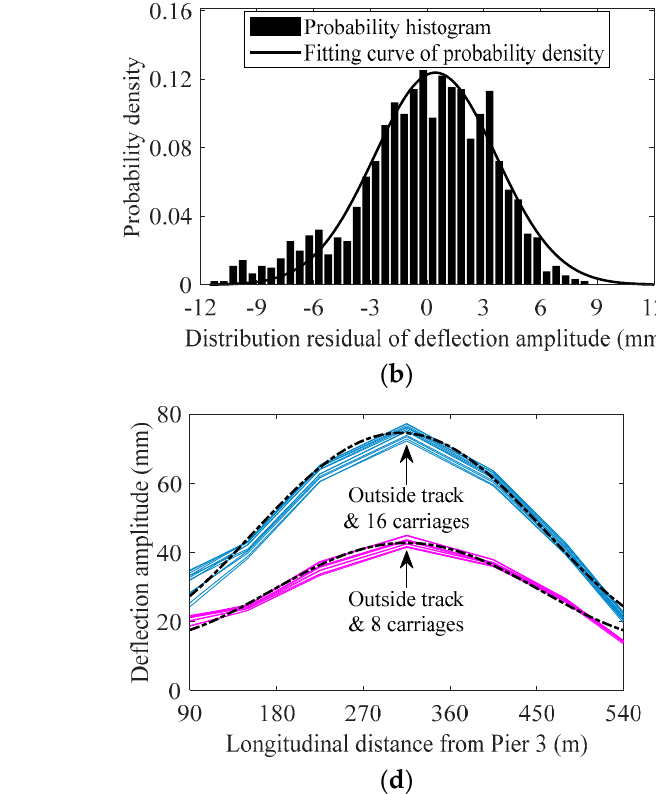
Figure 13. Characteristics and discussion of the distribution of train-induced deflection amplitude: ( a ) probability density analysis of typical DR td of the outside track and 8 carriages case; ( b ) probability density analysis of typical DR td of the outside track and 16 carriages case; ( c ) normal range of the outside track and 8 carriages case; ( d ) D C tdf of one year and the distribution of the centroid from each sensor ′ s 12 single-month data.